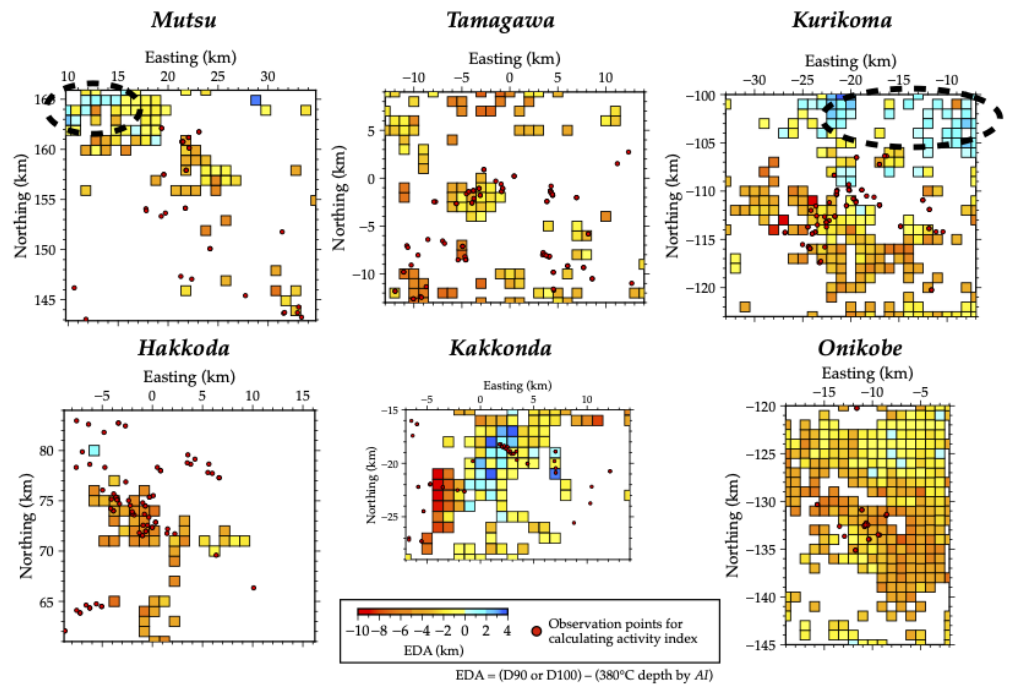
Figure 7. Map of the EDA distribution in each region. The points where no earthquake was registered and where the lower limit depth of the seismogenic layer could not be calculated are left blank. Red circles indicate data positions used to calculate the activity index.